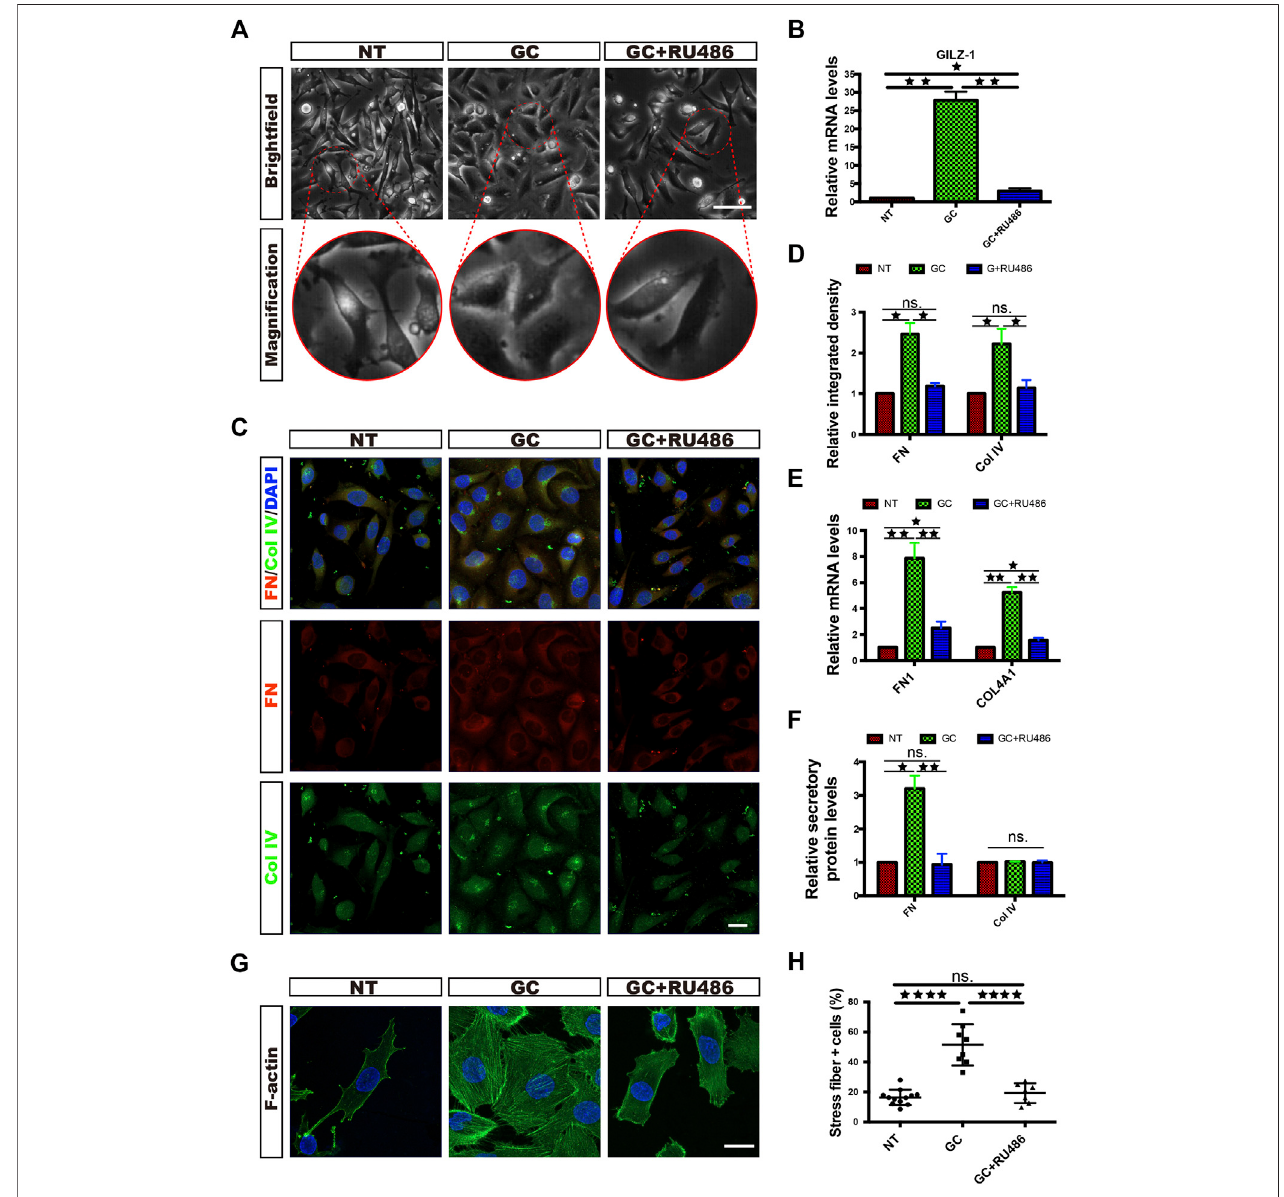
FIGURE 1 | GCs induce ECM component expression and morphological changes in HRCECs via a GC receptor. (A) : Bright fi eld microscopy images of HRCECs treated with 0.8 μ M hydrocortisone (GC) alone or in combination with 10 μ M RU486 (GC + RU486) for 72 h. The NT HRCECs were cultured in RPMI 1640 medium (Gibco) containing 10% FBS (Gibco). Scale bars, 100 μ m. (B) : Real-time qPCR analysis of GILZ in HRCECs treated as in (A) . (C) : FN/Col IV/DAPI immuno fl uorescence staining of HRCECs treated as in (A) . Scale bars, 20 μ m. (D) : Quanti fi cation of FN and Col IV integrated intensity of individual HRCECs treated as in (A) . (E) : Real- time qPCR analysis of FN1 and COL4A1 in HRCECs treated as in (A) . (F) : FN and Col IV secretion in supernatant of HRCECs treated as in (A) as analyzed via ELISA followed by normalization to NT group. (G) : F-actin was stained by immuno fl uorescence in HRCECs treated as in (A) . Scale bars, 20 μ m. (H) : Quanti fi cation of the percentage of cells displaying actin stress fi bers for the three treatment conditions in (A) . The error bars represent the mean ± SD, and the experiment was biologically repeated three times. * p < 0.05; ** p < 0.01; **** p < 0.0001; ns., not signi fi cant. Student ’ s two-tailed paired t-test (B,D,E,F) or Student ’ s two-tailed unpaired t-test (H) . ECM extracellular matrix, FN fi bronectin, Col IV type IV collagen.